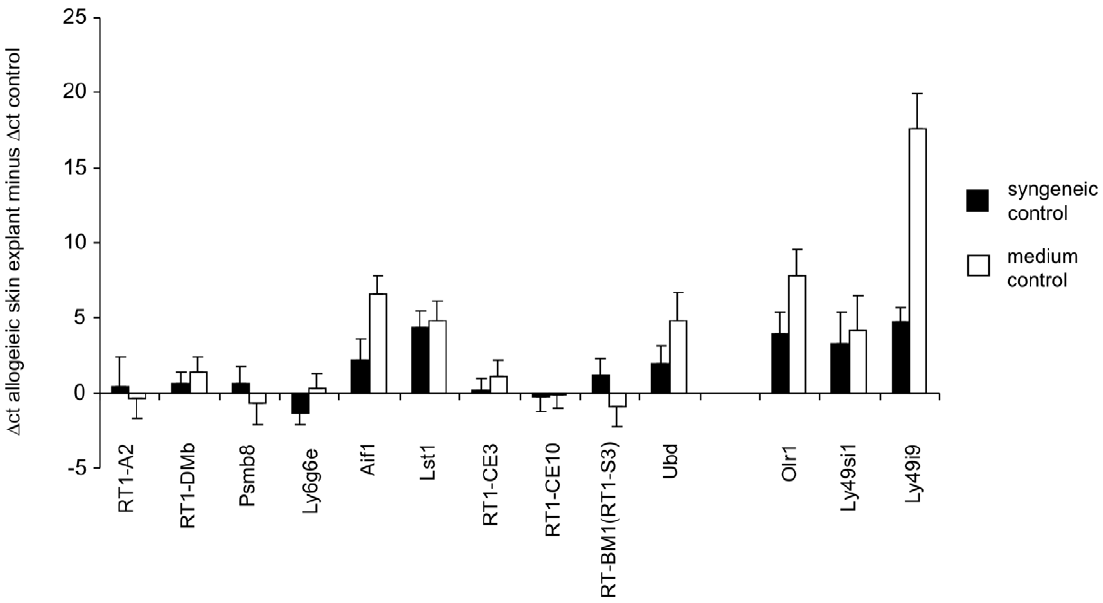
Figure 3. Verification of the regulation in gene expression observed in the microarray experiment by qRT-PCR. A subgroup of 8 samples used for the microarray experiment (see Fig. 1 ) was analyzed by qRT-PCR for the expression of 10 MHC and 3 NKC genes. The DD ct value was calculated, i.e. the D ct ( Gapdh – gene of interest) of the allogeneic skin explant samples minus D ct ( Gapdh – gene of interest) of the corresponding control sample. The control sample was either a parallel skin explant exposed to syngeneic lymphocytes as in the microarray experiment (syngeneic control, black bars) or a parallel skin explant sample cultured in medium only (medium control, white bars). The means of the DD ct values plus standard errors of the mean (SEM) are shown. A positive value indicates an up-regulation of gene expression in the allogeneic samples.